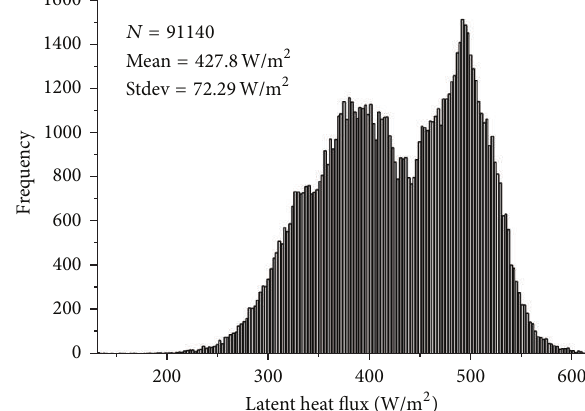
N = 4494 y = 1.083x−20.7